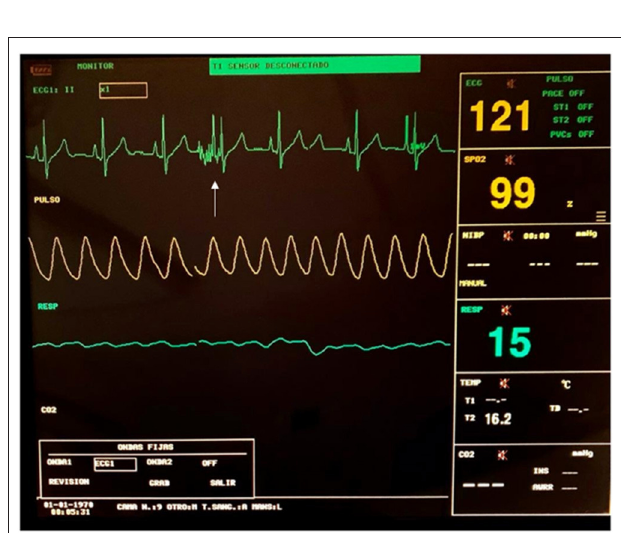
FIGURE 6 | ECG monitoring during an ECT procedure. An artifact can be seen during the delivery of the pulses (white